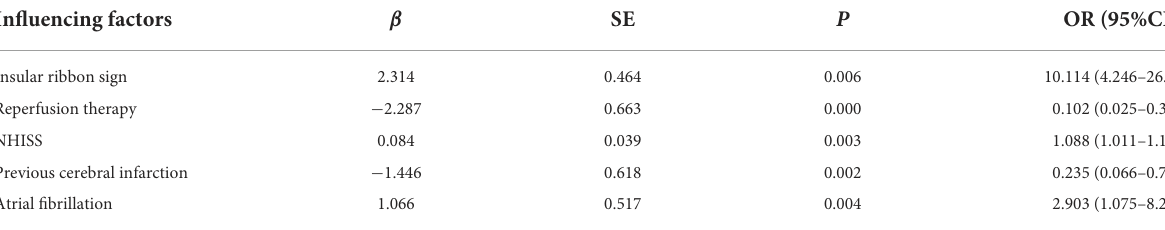
TABLE 2 Results of each factor analysis in the logistic regression model of MCI.